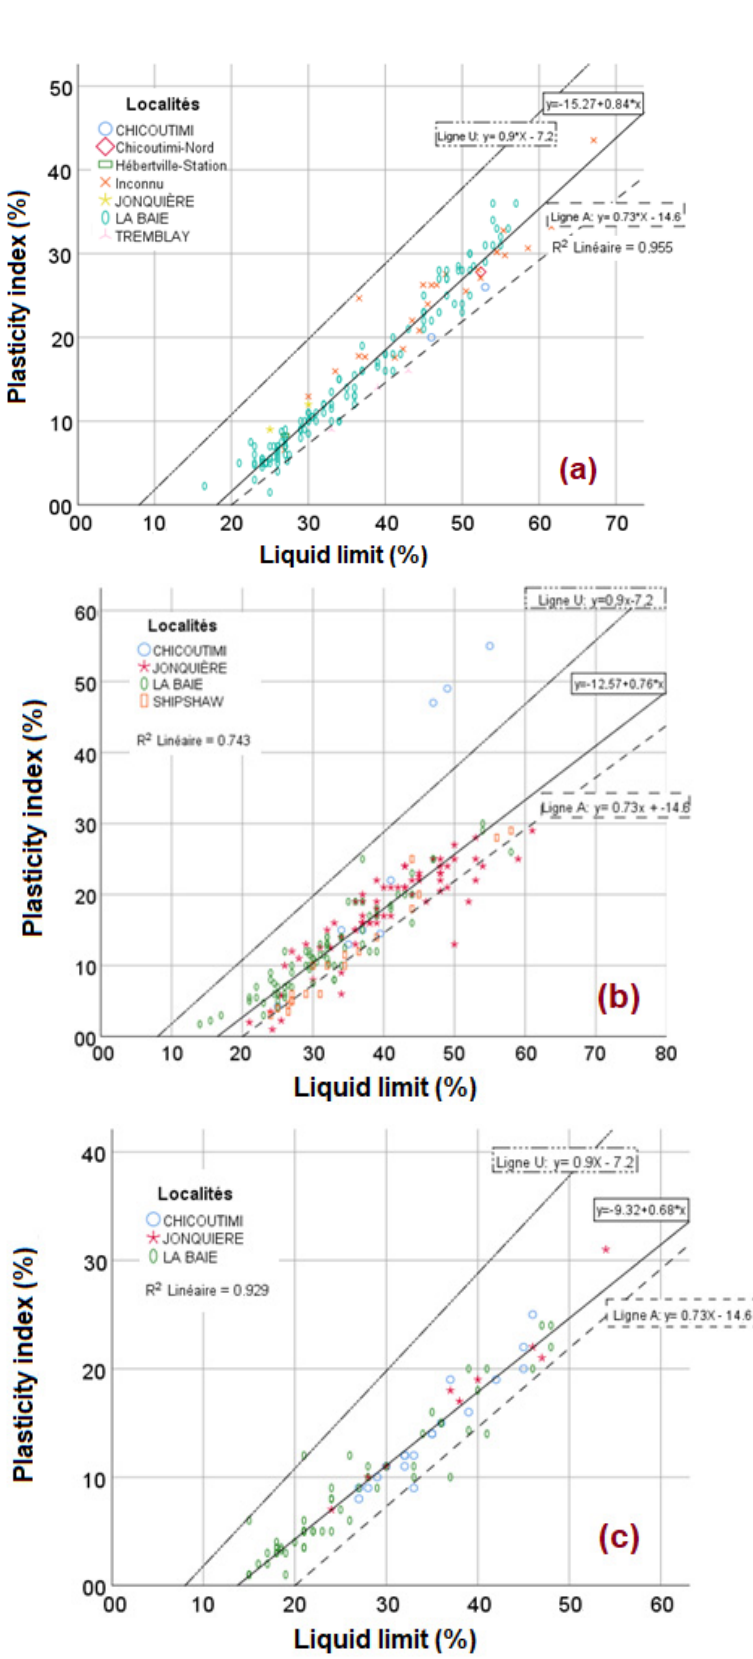
Figure 13. Linear relationship between the plasticity index and the liquid limit for ( a ) clay samples; ( b ) clay and silt samples; ( c ) silt samples.